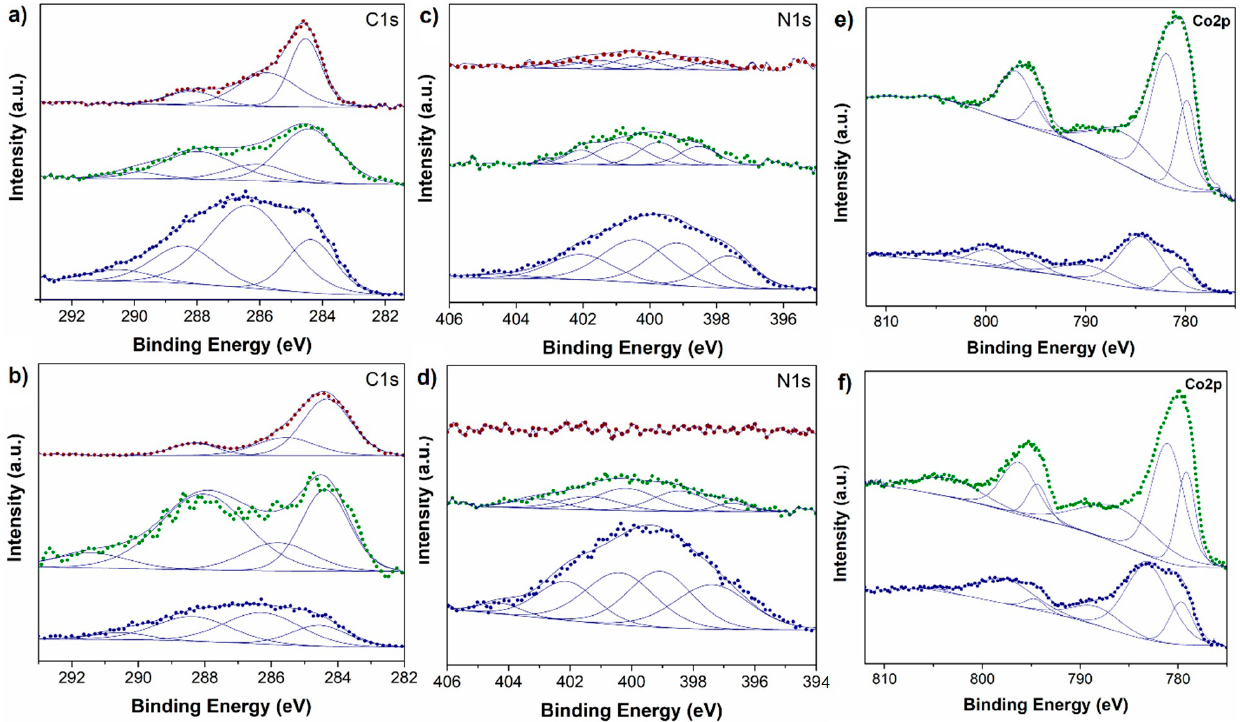
Figure 2. XPS spectra of representative polyacrylonitrile-based Co-N-doped carbon samples prepared under air atmosphere (PAN-A) in the ( a ): C1s, ( c ): N 1s, and ( e ): Co2p regions. XPS spectra of representative polyacrylonitrile-based Co-N-doped carbon samples prepared under N 2 atmosphere (PAN-N) in the ( b ): C1s, ( d ): N 1s, and ( f ): Co2p regions. Blue line: unmodified PAN based materials; green line: 3% Co modified materials; red line: 10% Co modified materials.